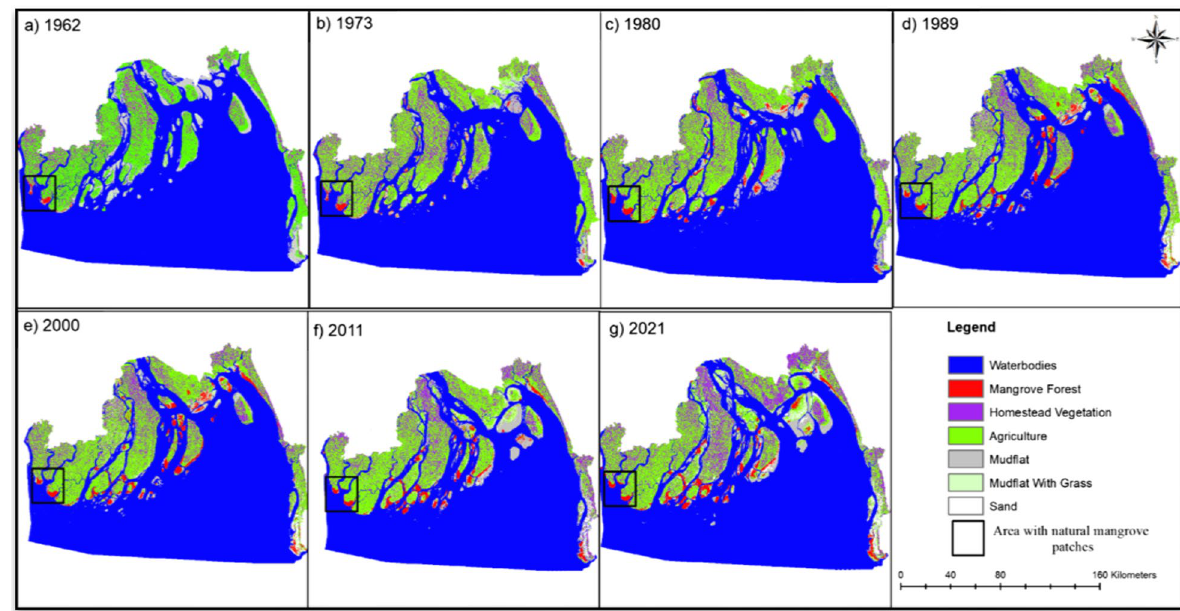
Fig. 5 Land use and land cover data from 1962–2021. The red-colored mangrove forest represents GoB’s NBS interventions except for the areas marked in the black box